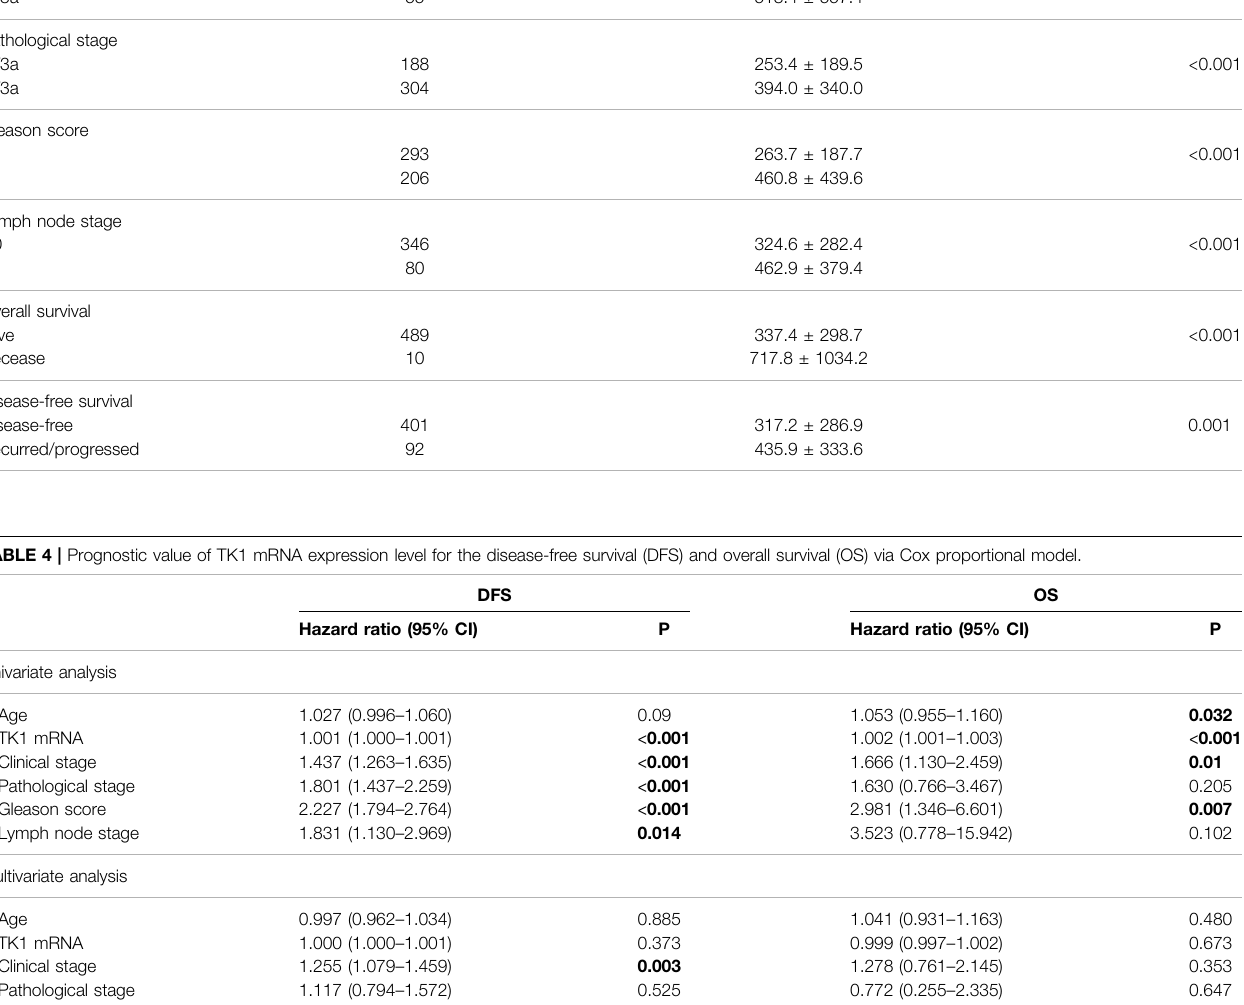
The bold values in Table 4 represent values less than 0.05 and are statistically signi fi cant.